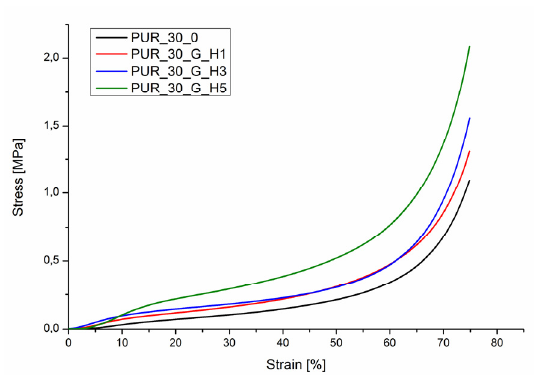
Figure 3. Compression stress–strain curves for PUR30_0, PUR30_G_H1, PUR30_G_H3, and